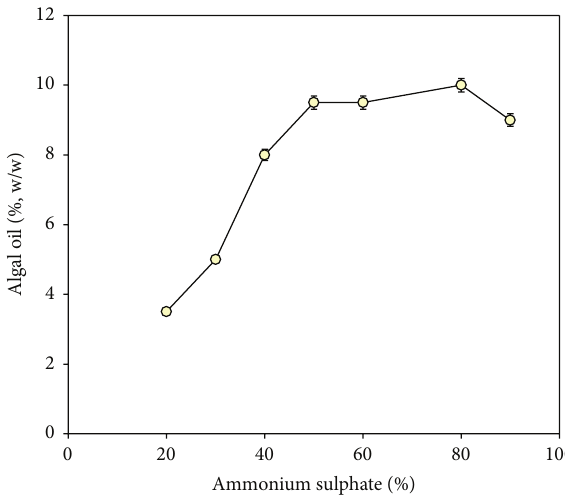
Figure 1: Effect of change in concentration of ammonium sulphate during TPP on oil yield (%, w/w). The aqueous algal suspension was ultrasonicated and was subjected to TPP at 40 ∘ C as described in the methods, Section 2.5. Ammonium sulphate concentration was varied (%, w/v) and in each case the oil obtained was expressed in terms of %, w/w, dry weight of algae. Each set was performed in triplicate and the deviation between the sets of experimental data was within 2%.